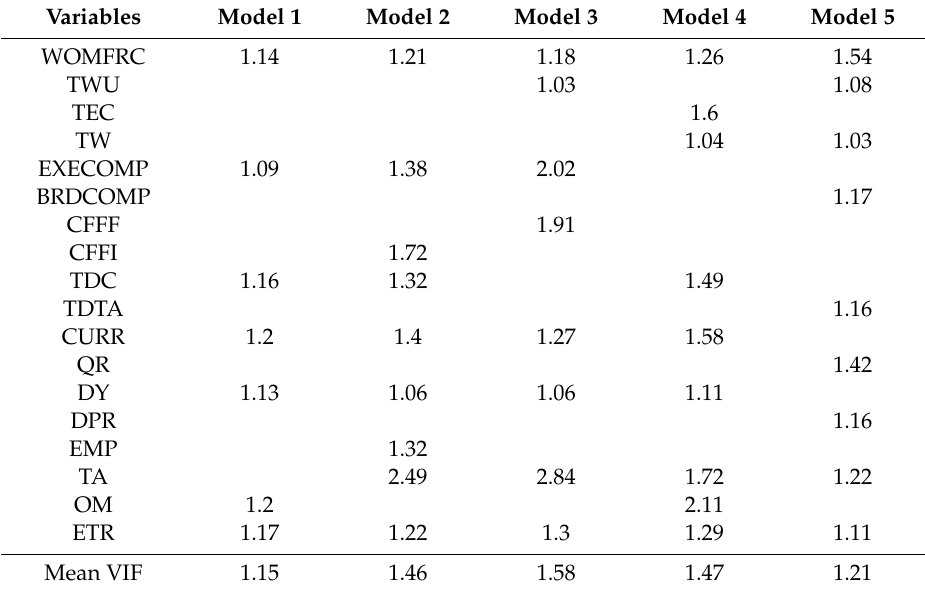
Table 10. VIFs for the panel data pooled regression models regarding the influence of water, waste, and energy consumption, alongside firm and corporate governance-specific variables, on price-to-book